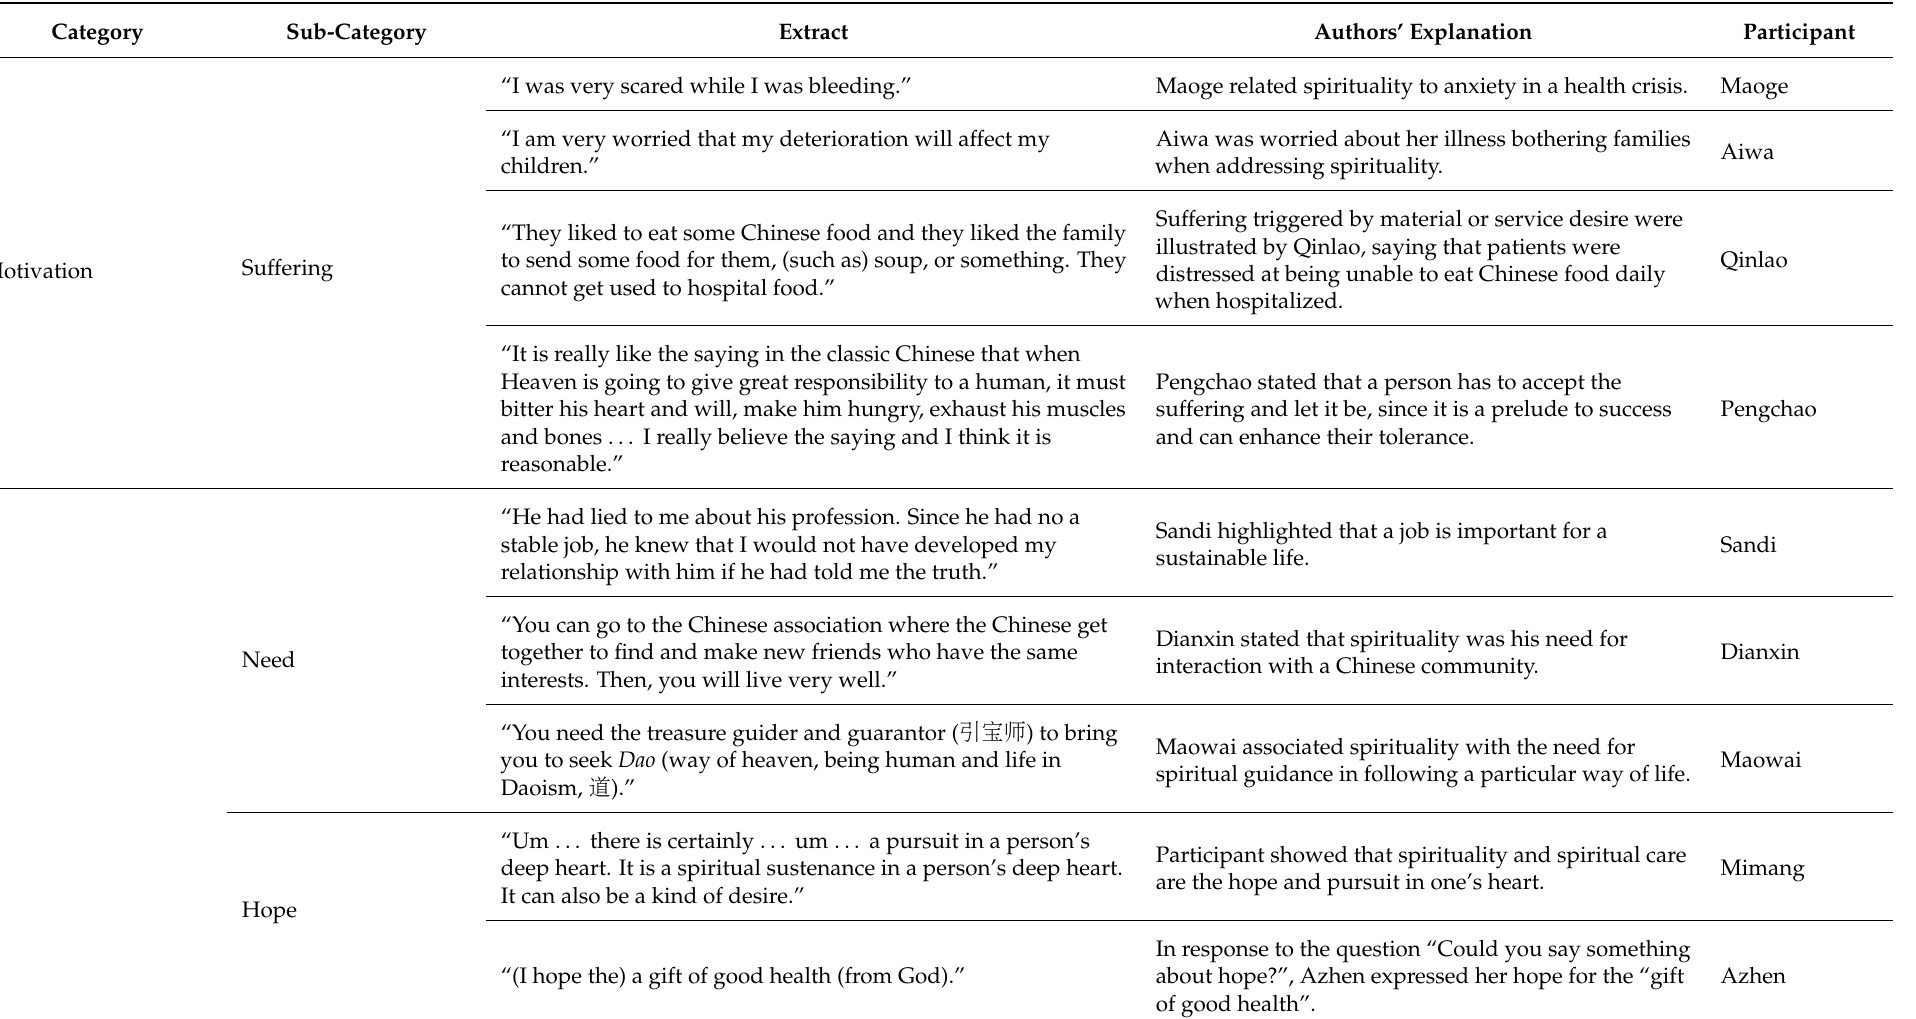
Table 3. The elements of the core category and example